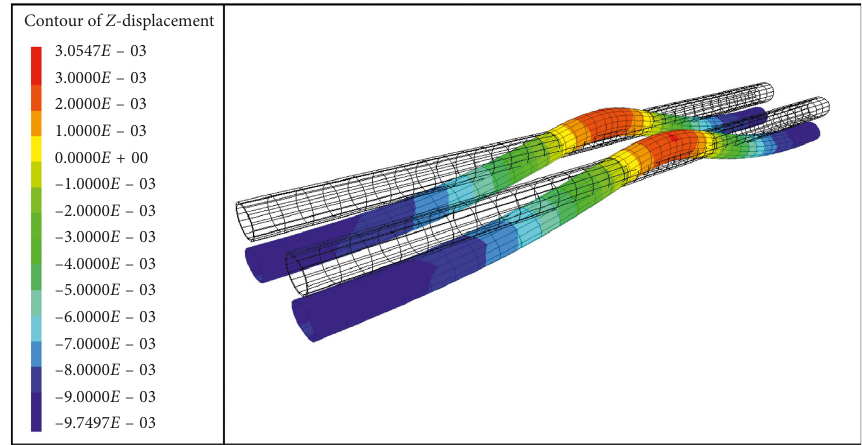
Figure 16: Contour of tunnel deformation in the excavation mode of W 3 by dewatering of jumping layer.